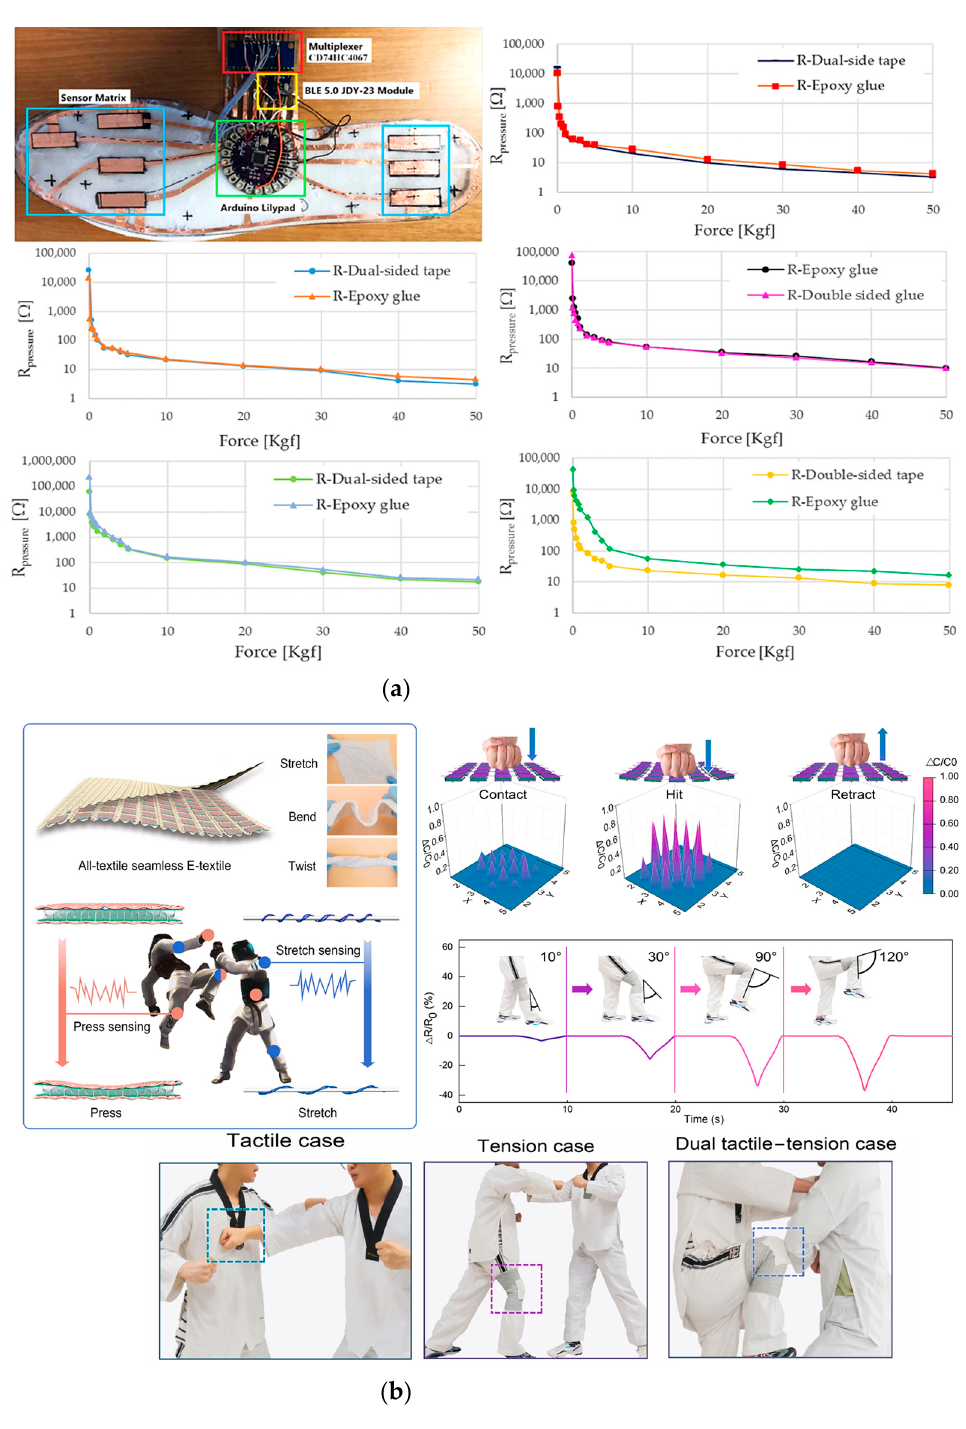
Figure 12. Examples of capacitive and piezoresistive hybrid sensors: ( a ) The developed sole with the piezoelectric integrated sensors, the acquisition system, and the Bluetooth module. Below, the characteristic curves R vs. F (in Kgf and with a logarithmic scale) for five Velostat-based pressure sensors are shown for different sizes, 3 cm × 3 cm, 1 cm × 1 cm, and 3 cm × 1 cm [63]. The yarn matrix structure in the inset shows some examples of the final fabric’s elongation, bending, and twisting ( b ). A map of the pressure distribution during the hit cycle and resistance variation at different knee bending angles are shown on the right. Some practical scenarios of using the integrated sensor on the chest and knee are also reported